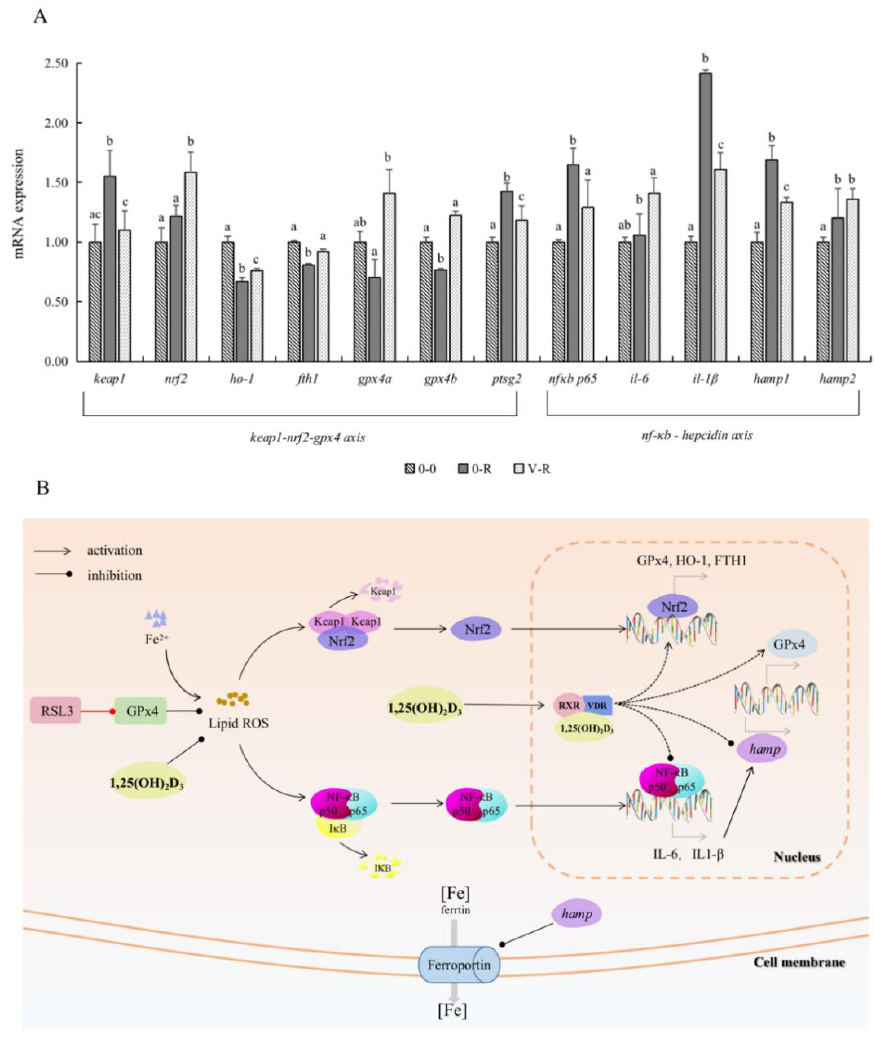
Figure 6. Effects of 1,25(OH) 2 D 3 on the gene expression related to the Keap1-Nrf2-GPx4 and NF- Figure 6 . Effects of 1,25(OH) 2 D 3 on the gene expression related to the Keap1 – Nrf2 – GPx4 and NF- κ B-hepcidin axis ( A ) and visualization of Keap1-Nrf2-GPx4 axis and NF- κ B-hepcidin axis ( B ). ZFL κB– hepcidin axis ( A ) and visualization of Keap1 – Nrf2 – GPx4 axis and NF- κB– hepcidin axis ( B ). ZFL were collected for qPCR after being preincubated with 200 pM 1,25(OH) 2 D 3 for 72 h and then treated with 3 µ M RSL3 for 6 h. Values are presented as means ( n = 6) and error bars represent the standard error of each group. Means with different superscript letters (a, b, c) are significantly different ( p < 0.05), while the same letter means no statistical difference between two groups. Abbreviations in ( B ): RSL3, specific inhibitor of GPx4; GPx4, glutathione peroxidase 4; ROS, reactive oxygen